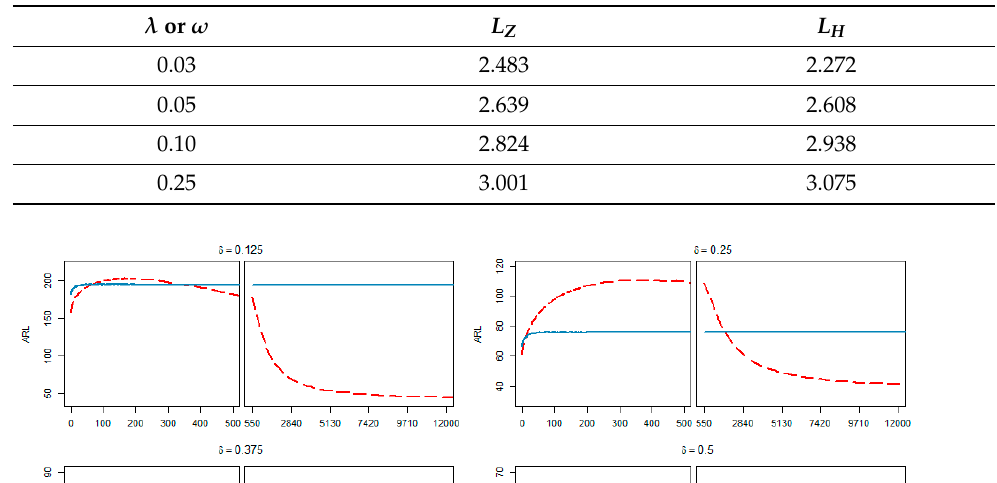
Table 1. L Z and L H of EWMA and HWMA charts.